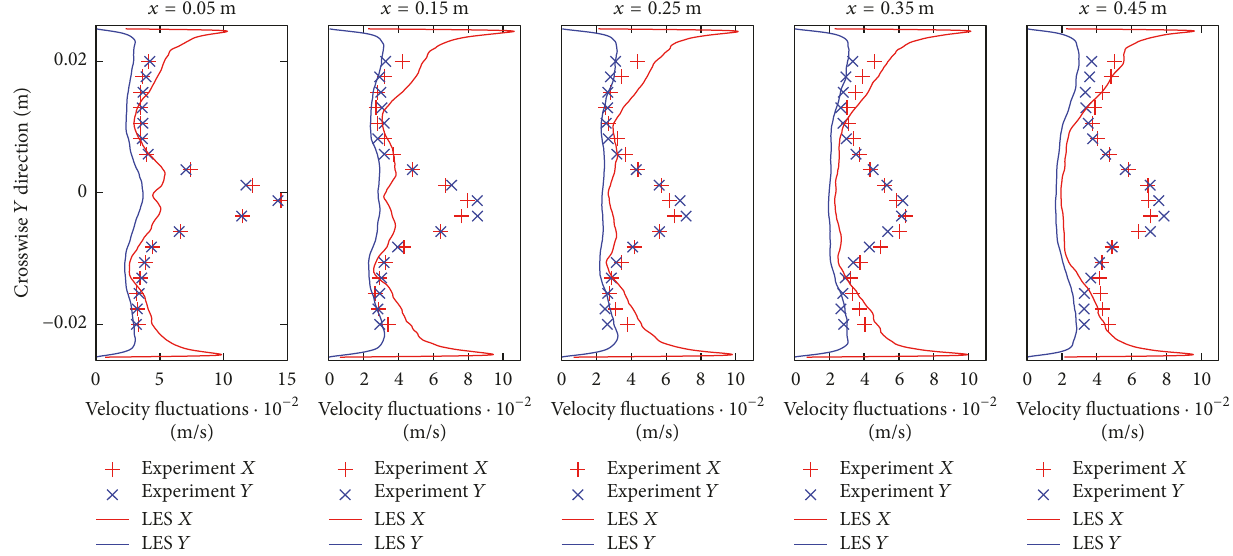
Figure 15: Velocity fluctuations profiles at different locations for two-liquid case.